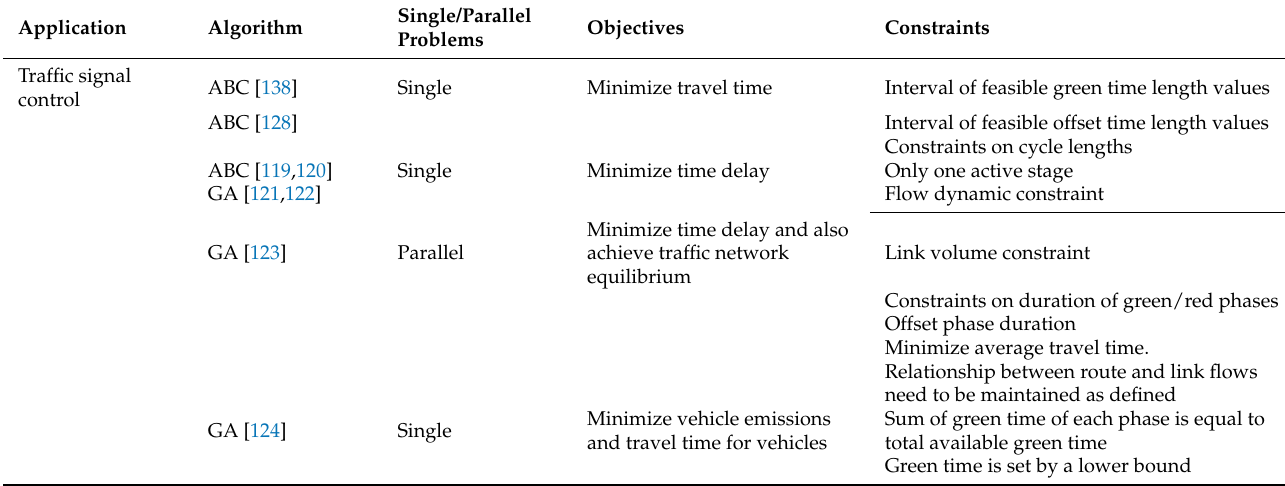
Table 15. Optimization in Smart